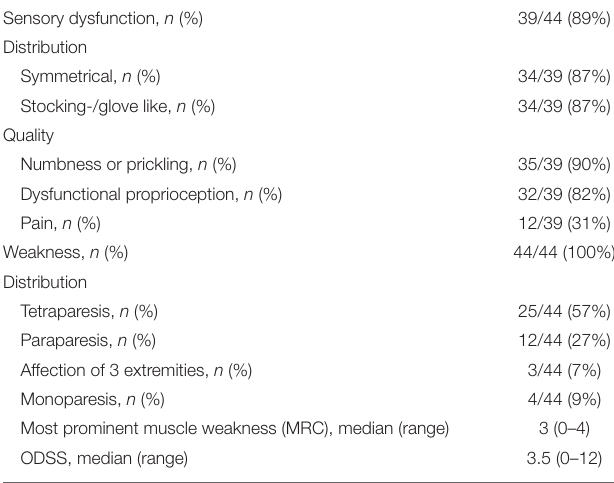
TABLE 4 | Neurologic findings in worst examination (judged by ODSS). Sensory dysfunction, n